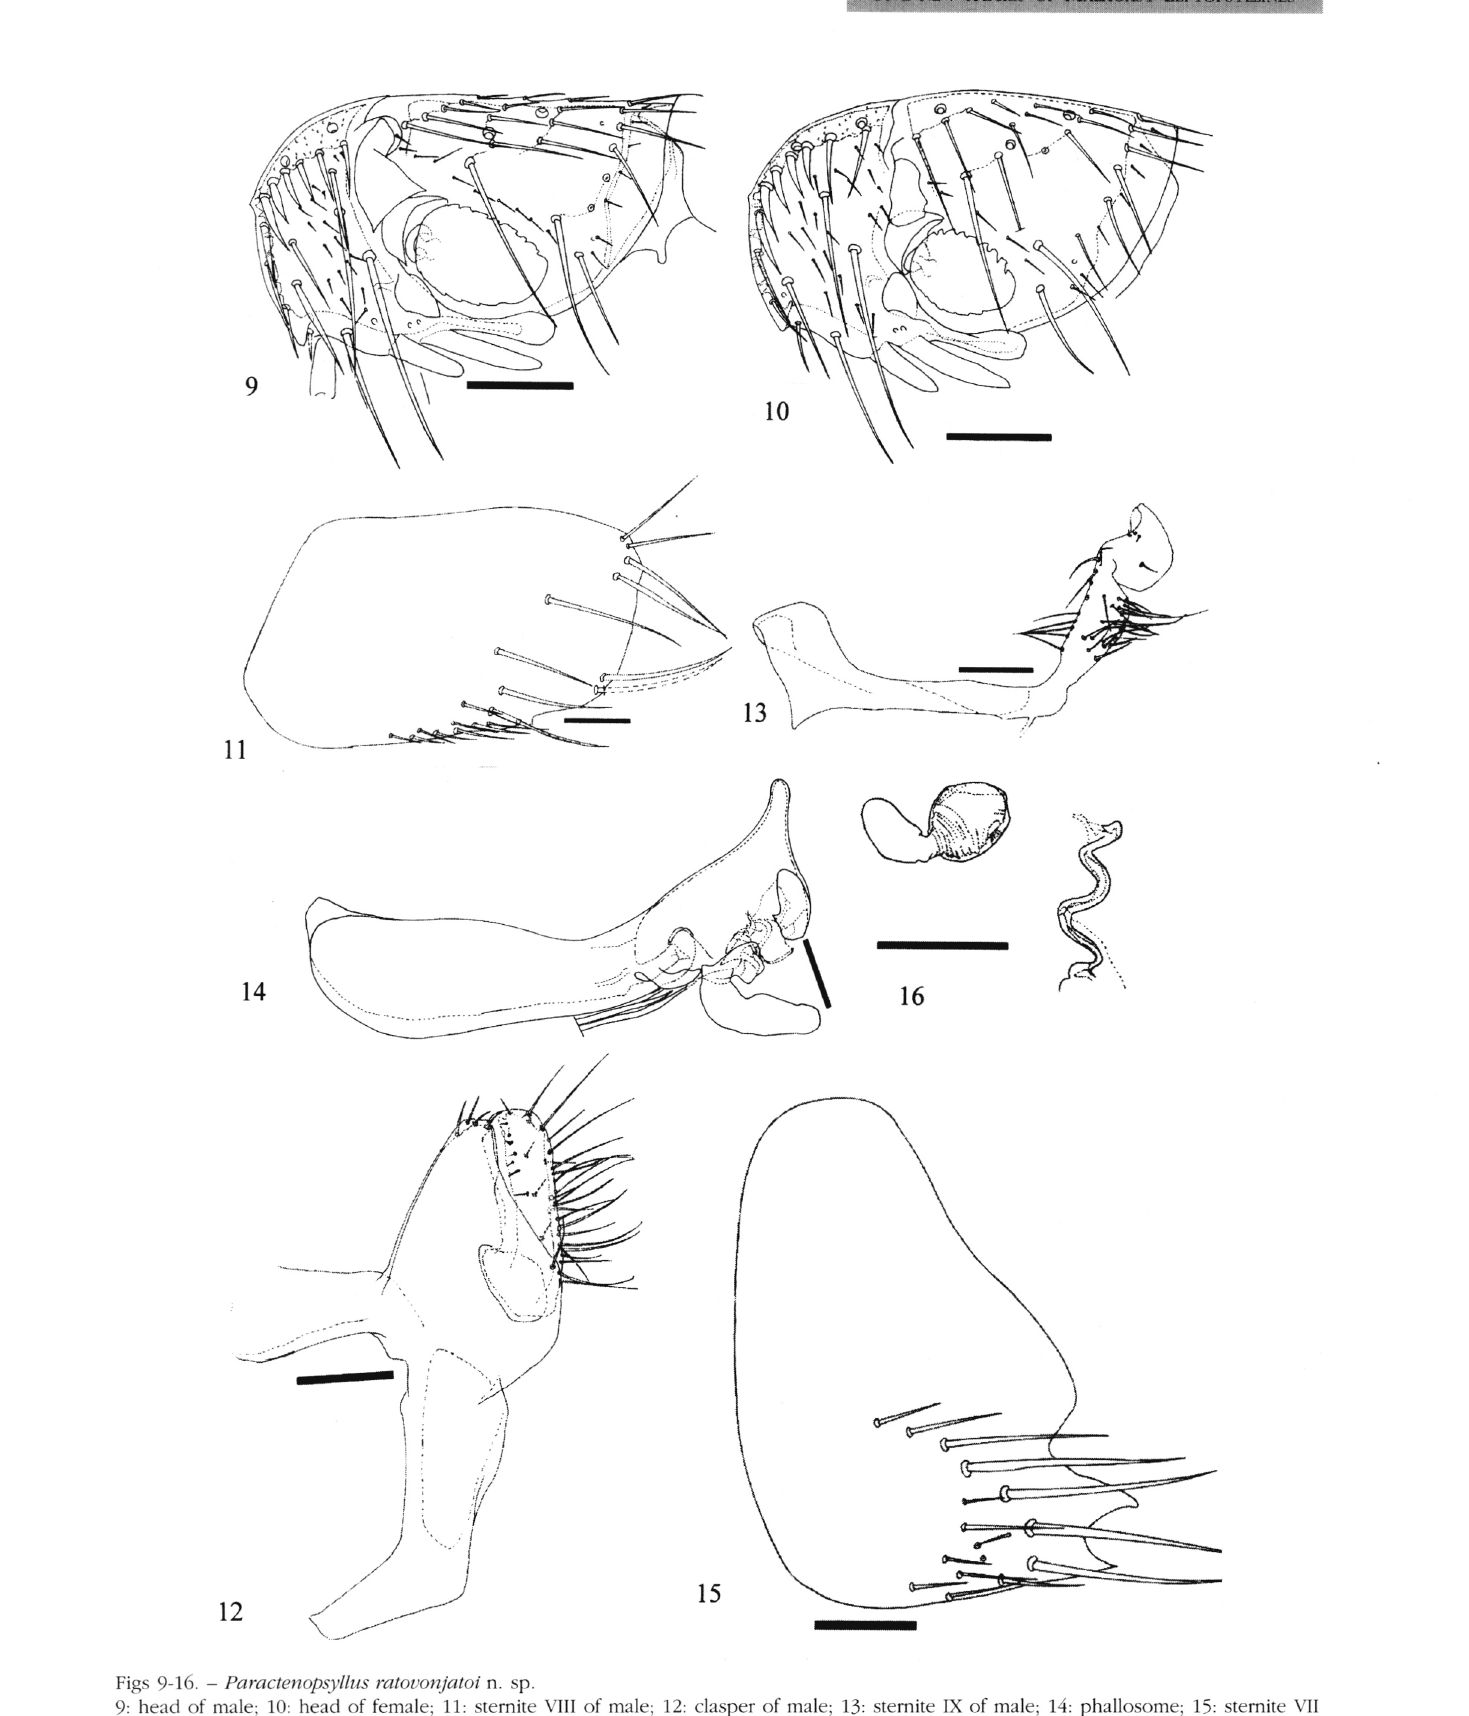
Figs 9-16. - Paractenopsyllus ratovonjatoi n. sp. 9: head of male; 10: head of female; 11: sternite VIII of male; 12: clasper of male; 13: sternite IX of male; 14: phallosome; 15: sternite VII of female; 16 : spermatheca and ductus bursae. All scale bars = 0,1